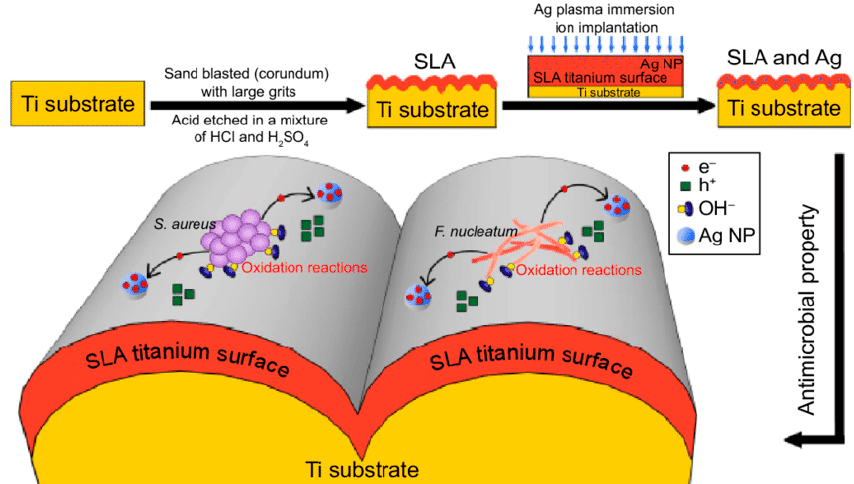
Figure 6. Schematic diagram of the fabrication procedures for the micro/nanostructured titanium and illustration for the possible antibacterial mechanism of the Ag NPs immobilized on the SLA-produced titanium oxide layer. Notes: 30 min-15 Ag-PIII, titanium surfaces treated by first SLA procedure and then silver plasma immersion ion implantation at 15 kV for 30 min; 60 min-15 Ag-PIII, titanium surfaces treated by first SLA procedure and then silver plasma immersion ion implantation at 15 kV for 60 min; 90 min-15 Ag-PIII, titanium surfaces treated by first SLA procedure and then silver plasma immersion ion implantation at 15 kV for 90 min. Abbreviations: Ag NPs, silver nanoparticles; SLA, sandblasted, large grit, and acid-etched; Ag-PIII, silver plasma immersion ion implantation; min, minutes. Reprinted with permission from [55] under Creative Common